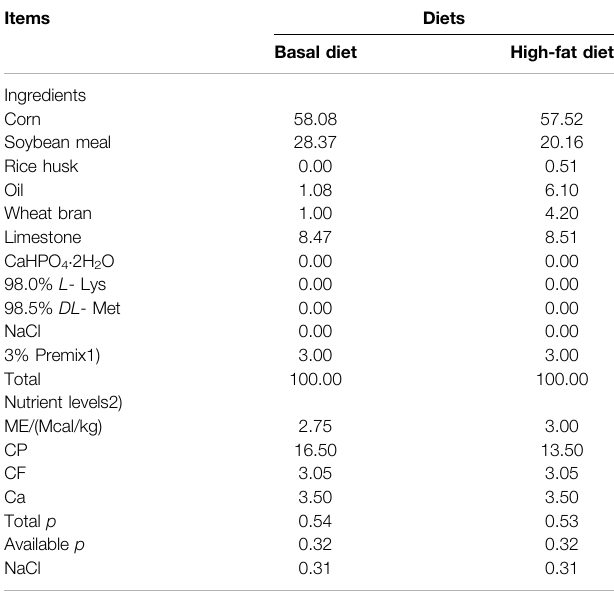
TABLE 1 | Composition and nutrient levels of experimental diets (air-dried basis) %. Items